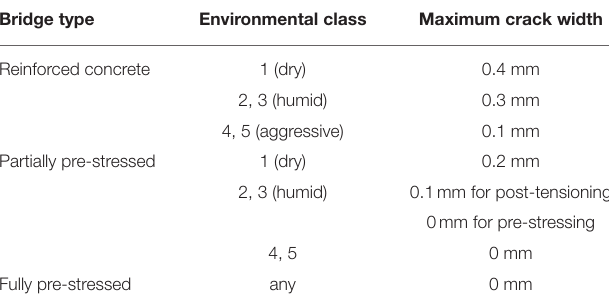
TABLE 3 | Limitations to crack widths that can occur in a load test for reinforced concrete bridges (Frýba and Pirner,